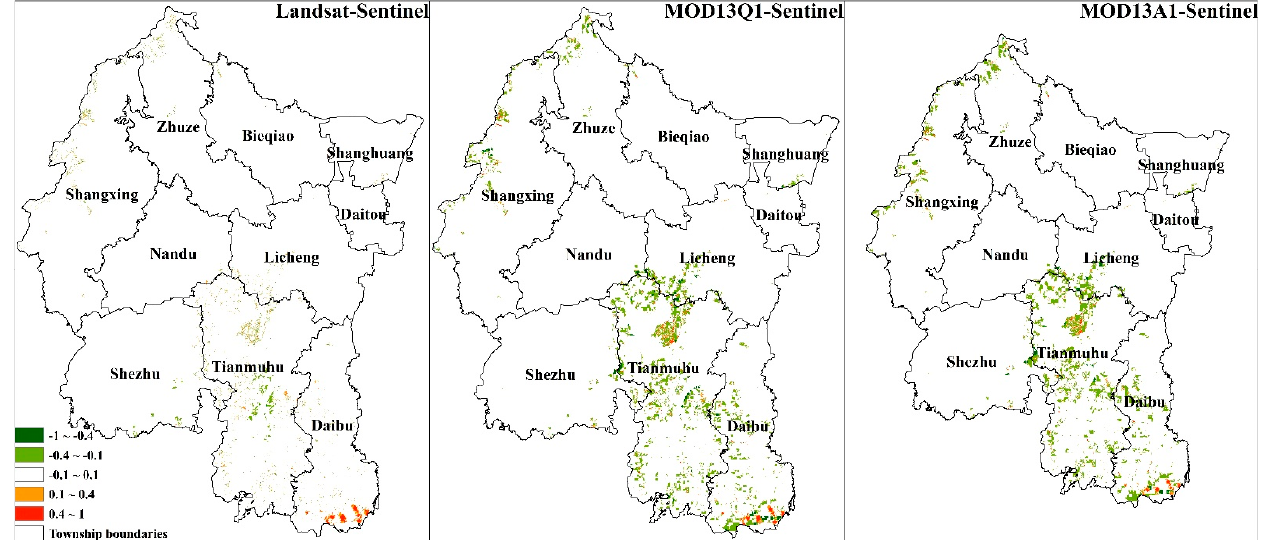
Figure 4. Spatial distributions of the difference between FVCs extracted using the stated spatial resolution and using 10 m resolution (Sentinel-2) images.